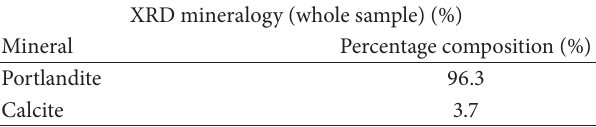
Table 6: Mineral composition of lime by XRD.